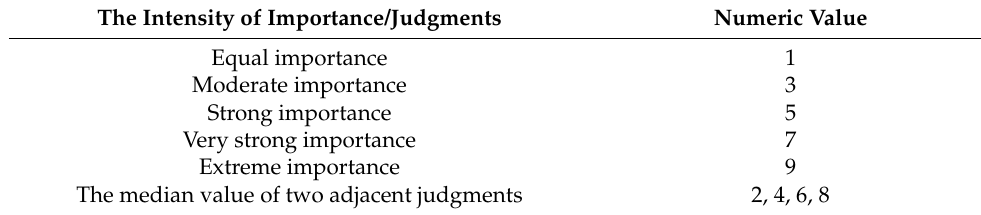
Table 2. Relative importance scale (1–9).